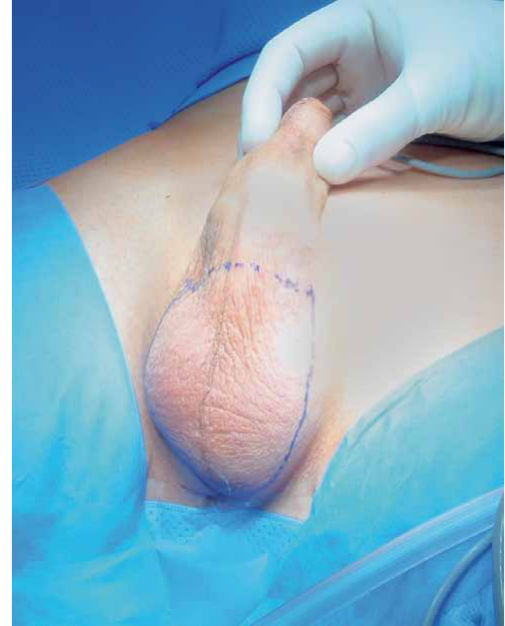
Figure 1 – Delimitation of the scrotal incision.